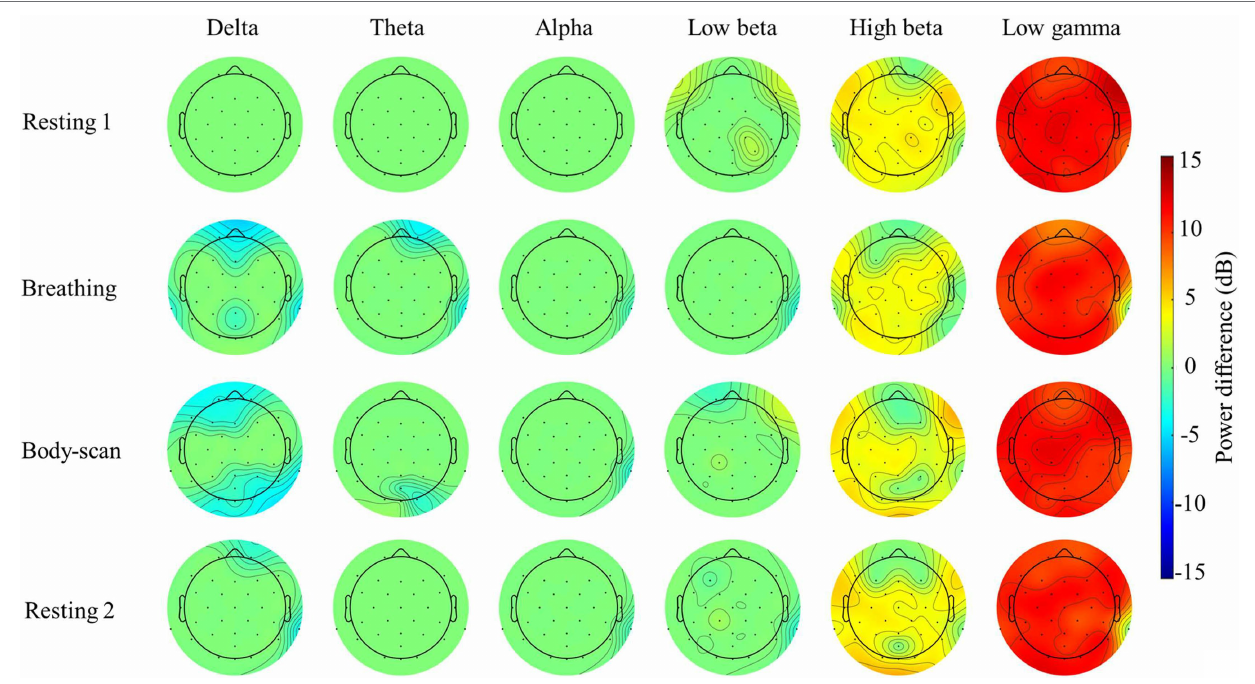
FIGURE 4 | Topoplot analysis of the Electroencephalograms (EEG) spectral power of the MSBR group in the breathing and body-scan tasks, and the paired t -test comparison between post-test and pre-test. Power difference = Post-test–pre-test power. Channel locations with zero power differences represent no significant difference (paired-sample t -test, FDR adjusted ps > 0.05, depicted in